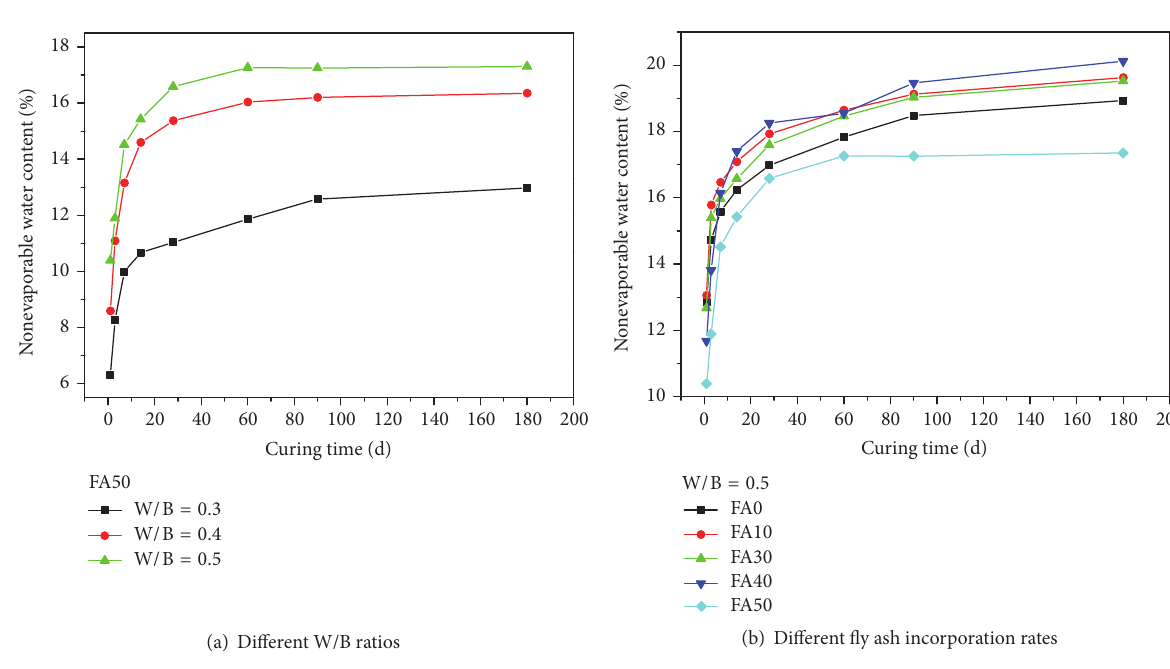
Figure 7: Nonevaporable water contents of the fly ash-cement blended